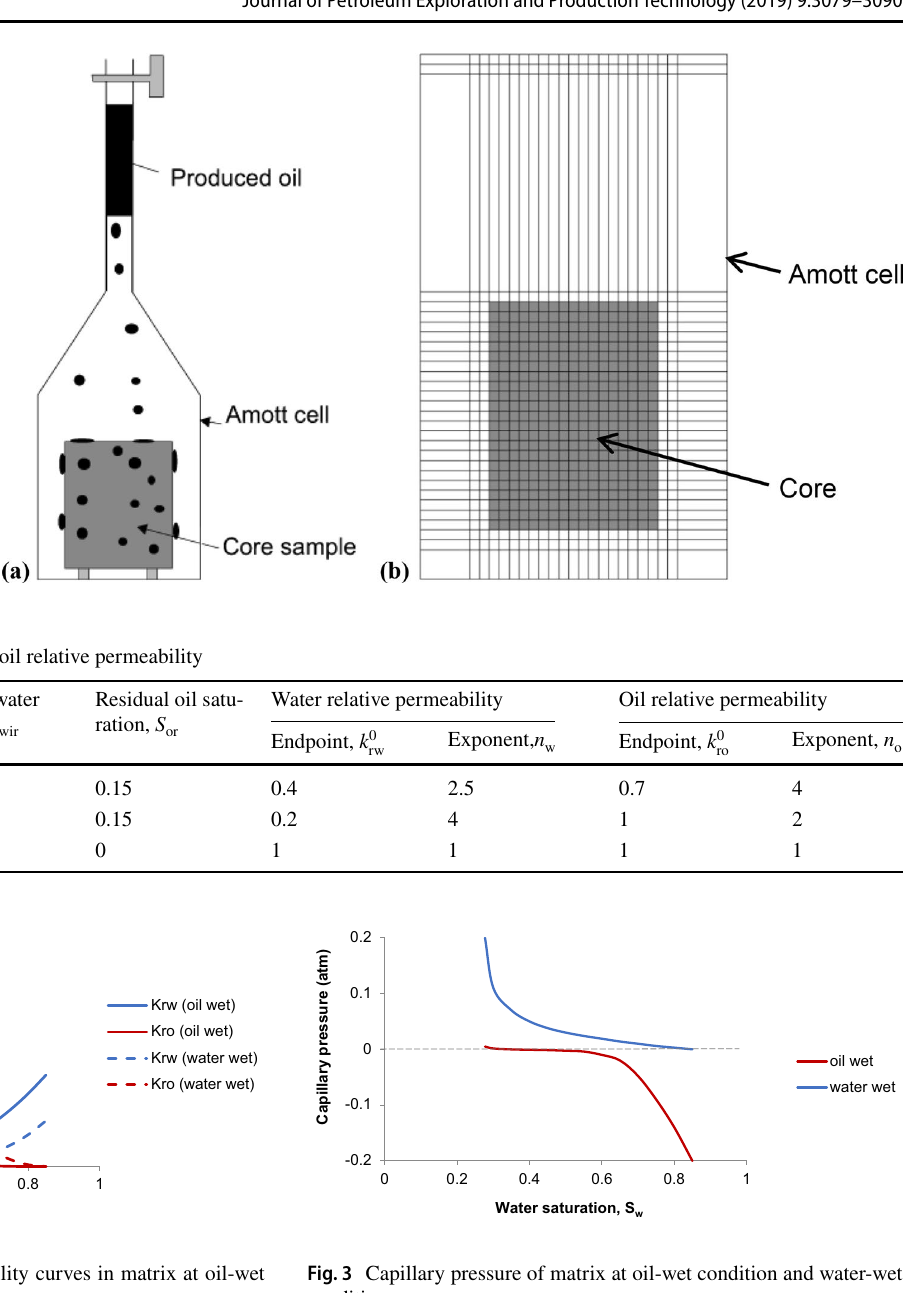
Fig. 2 Water and oil relative permeability curves in matrix at oil-wet condition and water-wet condition